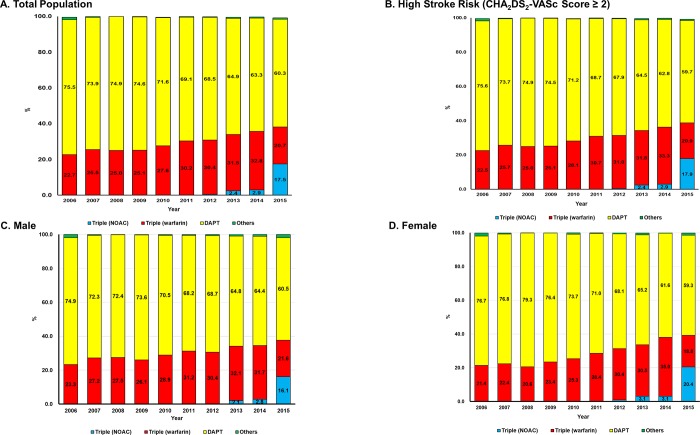
Temporal trends in antithrombotic treatment in patients with atrial fibrillation undergoing percutaneous coronary intervention.The 10-year trends in prescription patterns of antithrombotic therapy among patients with AF undergoing PCI are presented among the total population (a), those at high risk of stroke (CHA2DS2-VASc score ≥2) (b), and both male (c) and female (d) patients. Patients who received SAPT, OAC monotherapy, and dual therapy with OAC and SAPT were grouped into other types of antithrombotic therapy, as the prescription rates were very low. AF, atrial fibrillation; PCI, percutaneous coronary intervention; DAPT, dual antiplatelet therapy; NOAC, non-vitamin K antagonist oral anticoagulants.